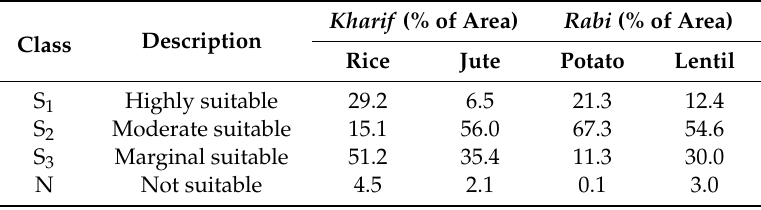
Table 9. Land suitability distribution for Kharif and Rabi season crops.